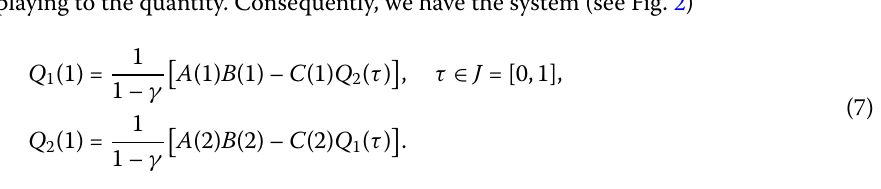
The sequence (cid:11) Q ( τ ) (cid:12) converges to the equilibrium point Q ∗ whenever max { C (1), C (2) } < 1 – γ , 0 < γ <